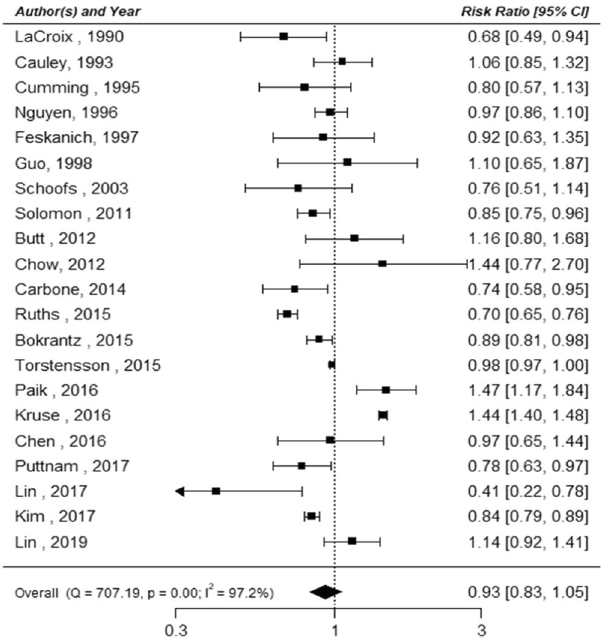
Figure 3. Association between thiazide use and fracture risk for cohort studies analyzed using the classical meta-analysis approach.